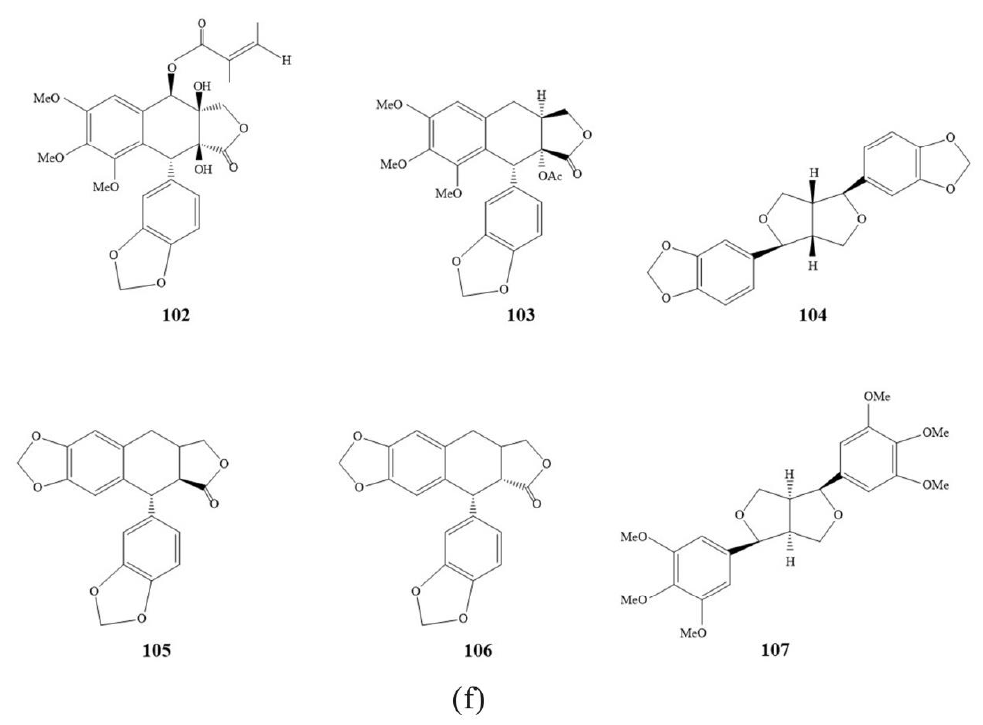
Figure 2. The structural patterns of some chemical constituents in myrrh. ( a ) Monoterpenes; ( b ) sesquiterpenes; ( c ) diterpenoids; ( d ) triterpenoids; ( e ) steroids; ( f ) lignans.